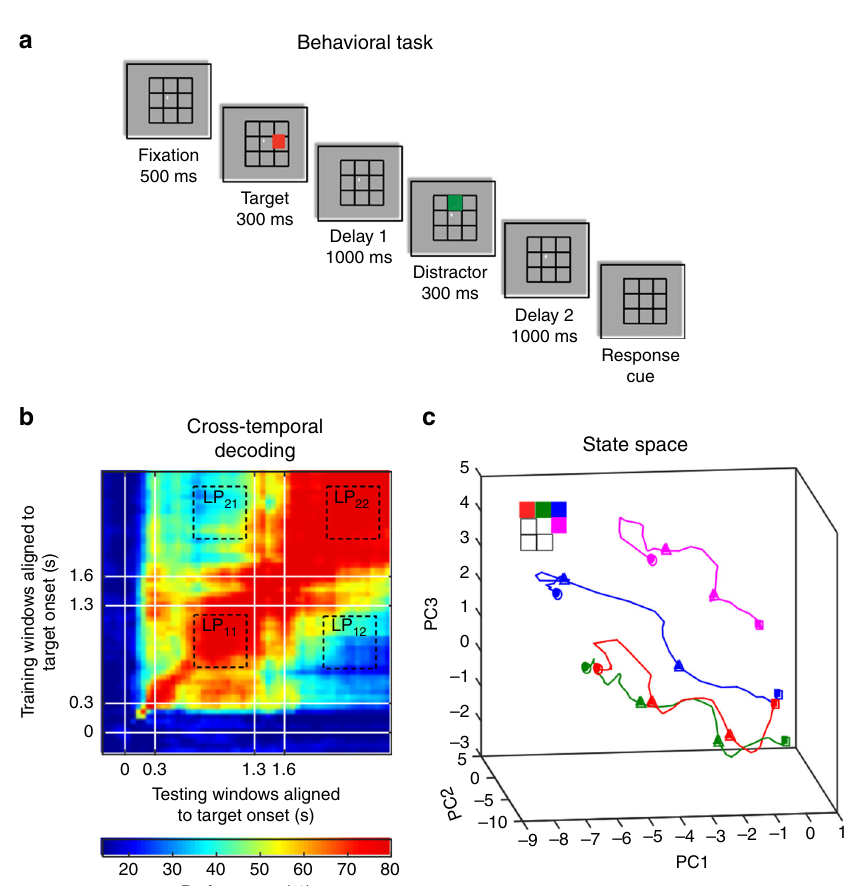
Fig. 1 Experimental design and code-morphing. a Behavioral task: each trial began when the animal fi xated on a fi xation spot in the center of the screen. The animal was required to maintain fi xation throughout the trial until the fi xation spot disappeared. A target (red square) was presented for 300 ms followed by a 1000-ms delay period (Delay 1). A distractor (green square) was then presented for 300 ms in a random location that was different from the target location, and was followed by a second delay of 1000 ms (Delay 2). After Delay 2, the fi xation spot disappeared, which was the Go cue for the animal to report, using an eye movement, the location of the target. b Heat map showing the cross-temporal population-decoding performance in the LPFC. White lines indicate target presentation (0 – 0.3 s) and distractor presentation (1.3 – 1.6 s). c Responses of the LPFC population when projected onto the fi rst three principal components (PC) of the combined Delay 1 and Delay 2 response space. The responses for different target locations are color-coded using the color scheme shown in the top left. The trajectories illustrate the evolution of the responses from 500 ms before the end of Delay 1 (square), distractor onset ( fi rst triangle), distractor offset (second triangle), and the end of Delay 2 (circle). The trajectories of only four of the seven target locations are shown here for